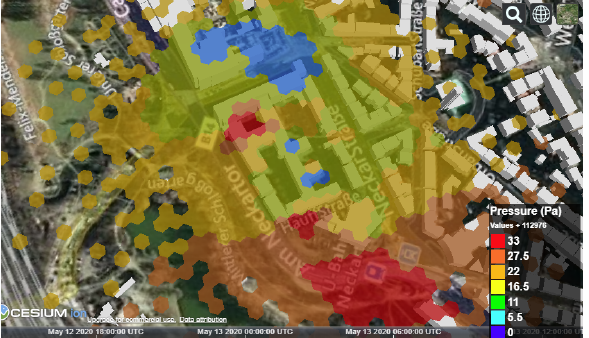
Figure 9. Pressure showing same building block as Figure 7. Wind pressure was averaged in the z-domain across the entire building height (slice height 31 m). Data were requested from the 3DPS as a hex-grid - layer (hexagon width of 15 m)